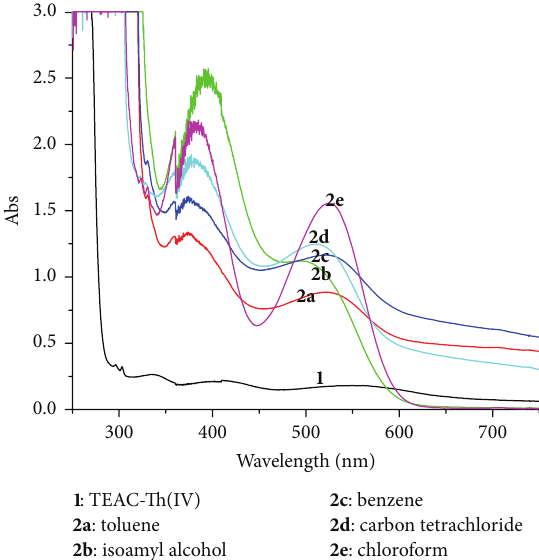
Figure 2: Absorption spectra of TEAC-Th(IV) before and after extraction with various solvents: (1) TEAC-Th(IV) in MeOH, 8 × 10 −6 M,and(2ato2e)TEAC-Th(IV)complexesafterextractionfrom 25 mL of complex solution into 5 mL solvent.